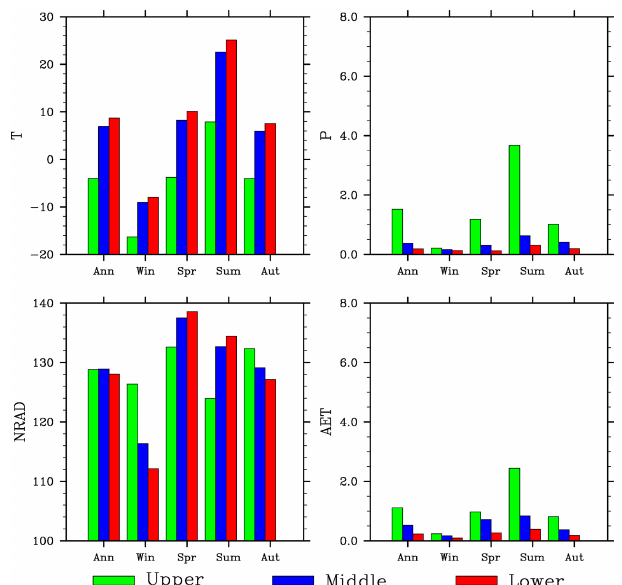
Figure 3. Seasonal variations of the simulated air temperature ( T , ◦ C), precipitation ( P , mmd − 1 ), net radiation (NRAD, Wm − 2 ), and actual evapotranspiration (mmd − 1 ) in three basin reaches averaged over 1980–2010.